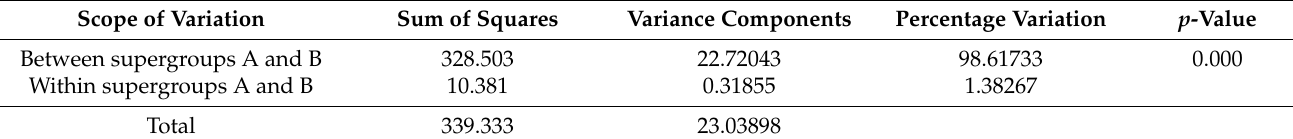
were restricted to the south face of the mountains, and supergroup B haplotypes to the northern face. The haplotype circle size represents the frequency observed, and the whiskers dividing distance lines indicate the numbers of nucleotide differences between haplotypes. Red dots were added by the software, suggesting a hypothetical haplotype. Table 2. AMOVA results among and within haplotype supergroups A and B of Solenopsis invicta fire ant populations sampled from two sides of a mount range in S ã o Paulo,